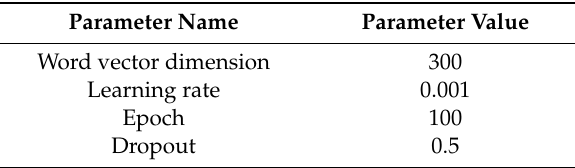
Table 4. Experimental parameter